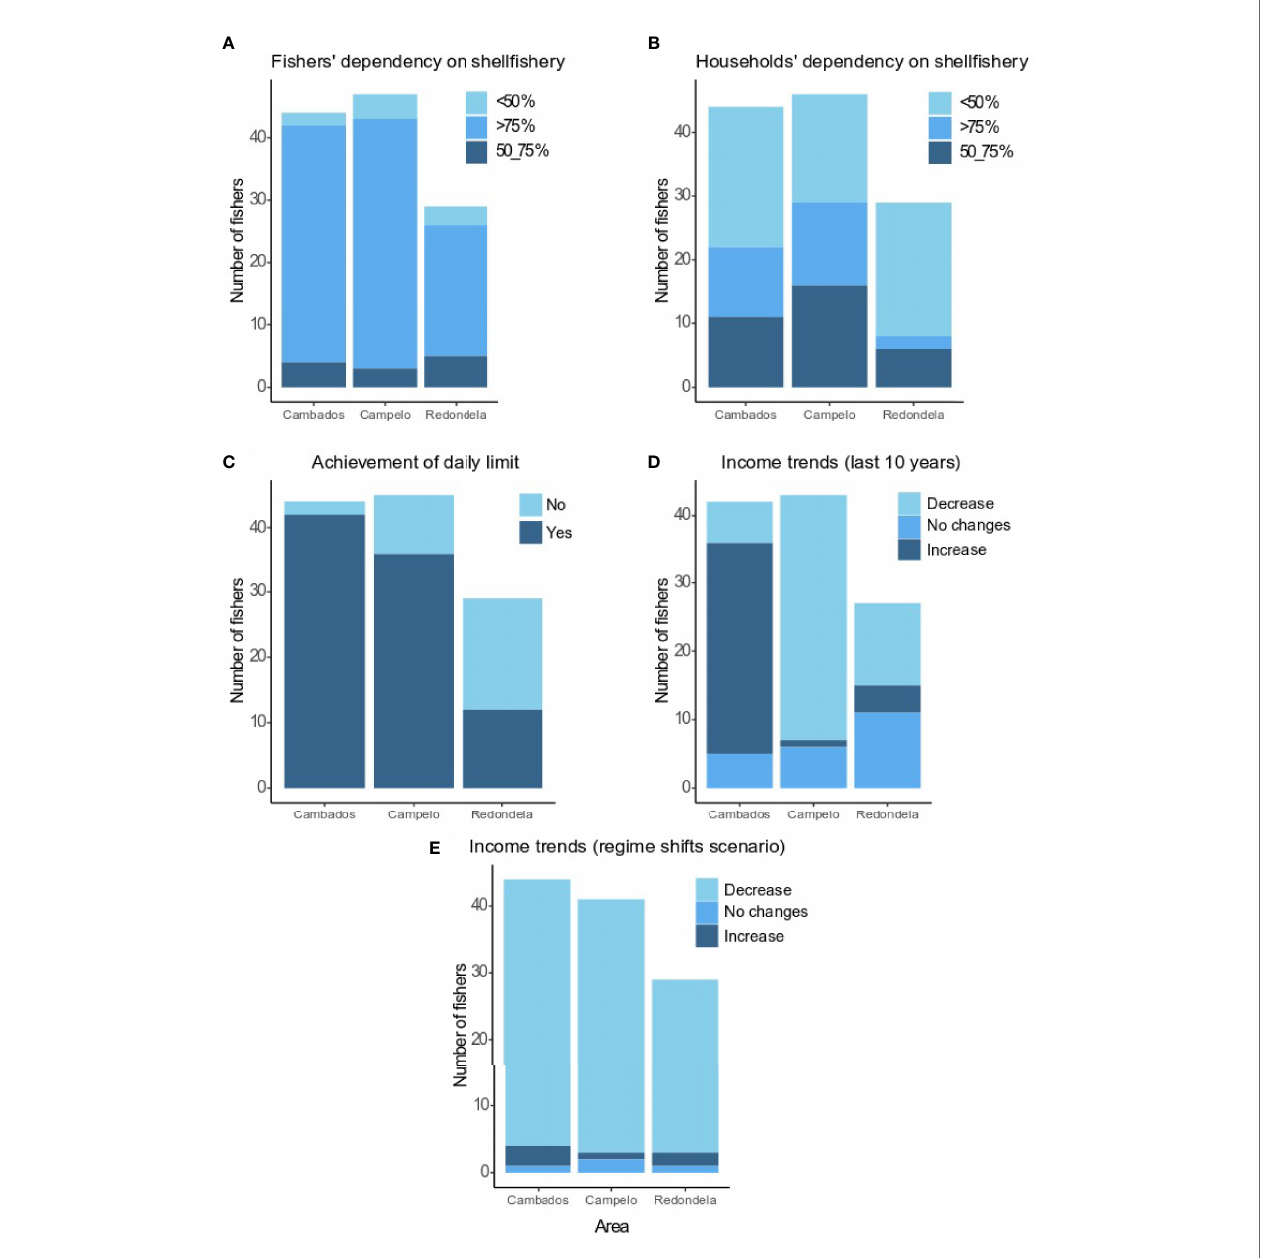
FIGURE 4 | Shell fi shery dependency on (A) fi shers and (B) households, and fi shers ’ perceptions on (C) the capture of daily quota, (D) income trends (in the last 10 years), and (E) consideration of future climate change scenarios by